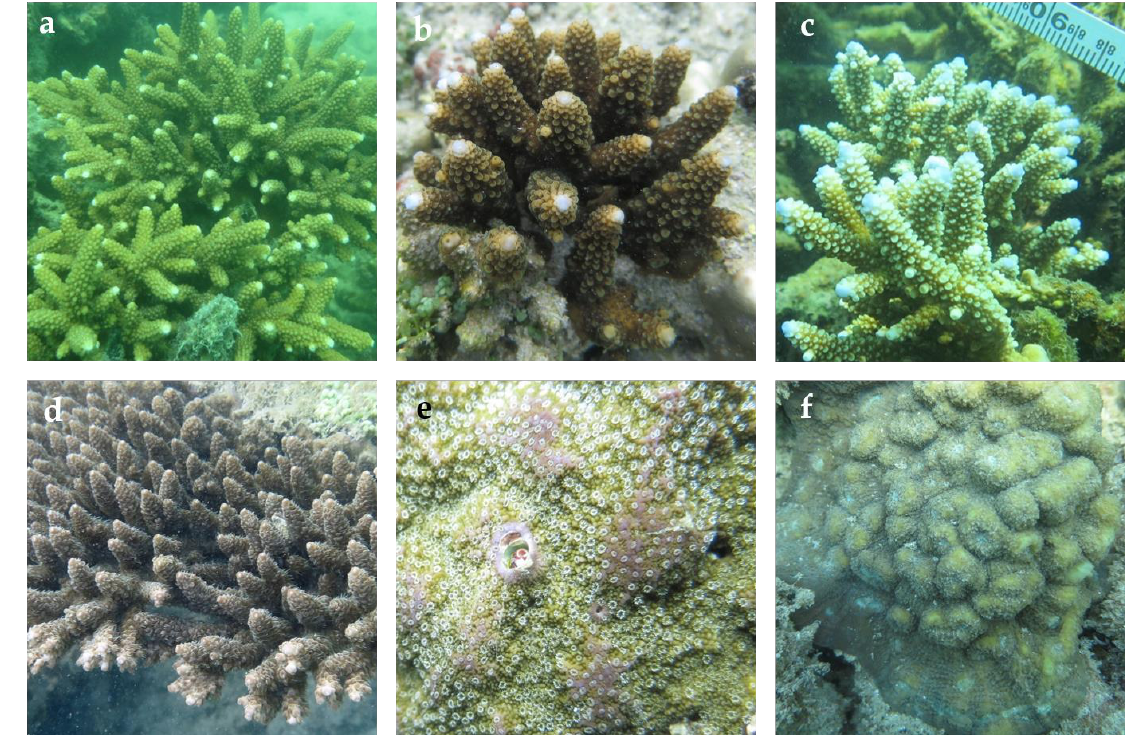
Figure 6. Species subjected to DNA barcoding: ( a ) Acropora aspera, ( b ) Acropora digitifera, ( c ) Acropora gemmifera, ( d ) Acropora hyacinthus, ( e ) Montipora flabellata, ( f ) Echinopora